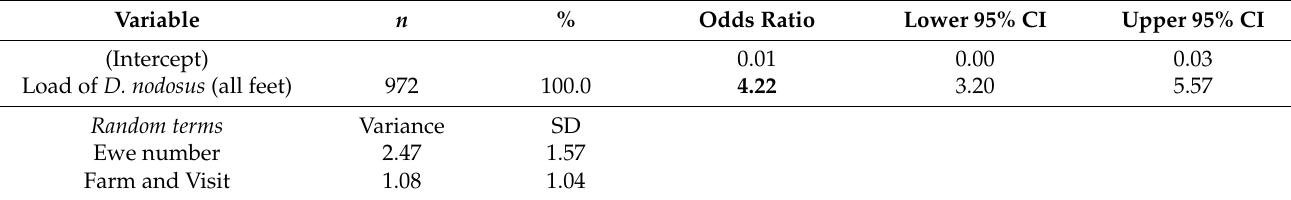
Table 8. Binomial mixed effects model of clinical status from 972 foot-level observations.